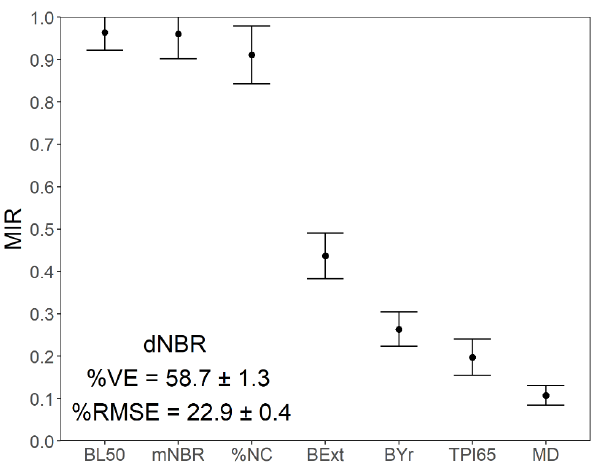
Figure 10. RF outputs for burn severity ( dNBR ) over 30 runs (Mean ± SD). Variable importance quantified by MIR. See Table 3 for full variable names and descriptions. %NC is the percentage of burned pixels in each fire comprised of nature conservation land use (Figures 1 and 8a).